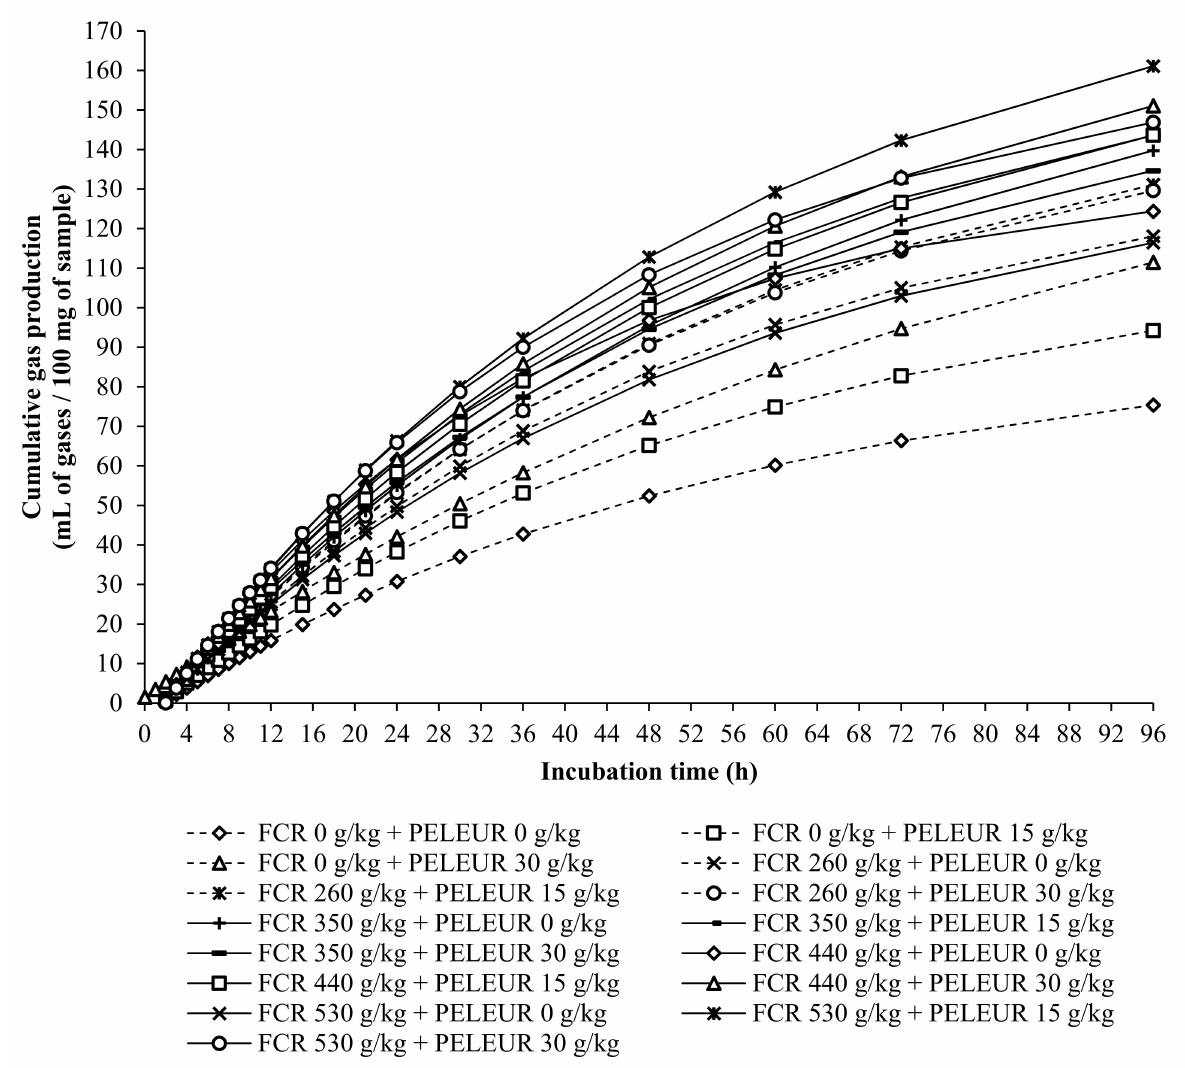
Figure 2. Effect of fresh cassava root (FCR) with pellets containing high sulfur (PELFUR) on cumulative gas during incubation